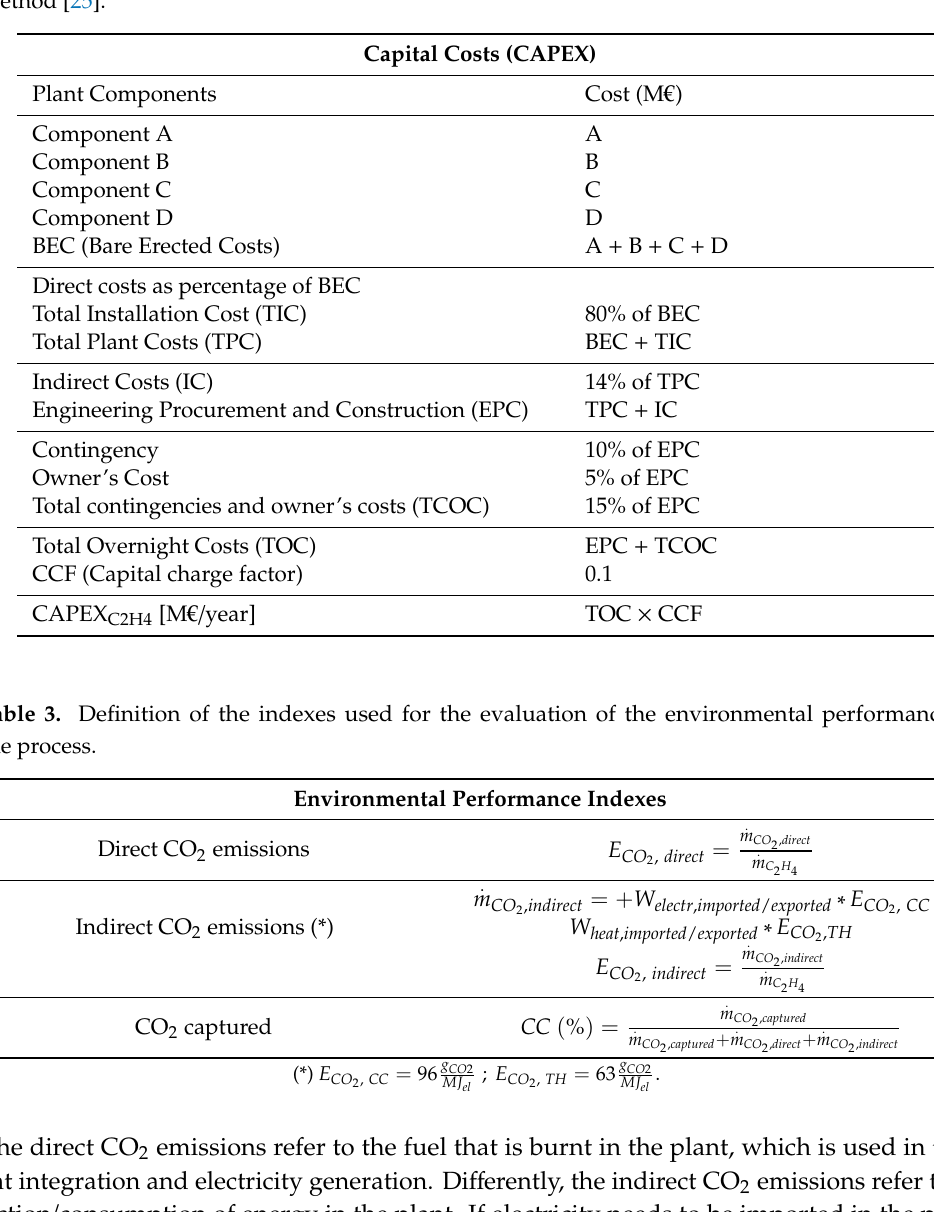
Table2. Capital(CAPEX)costscalculationsbyusingtheNETL(NationalEnergyTechnologyLaboratory) method [25].